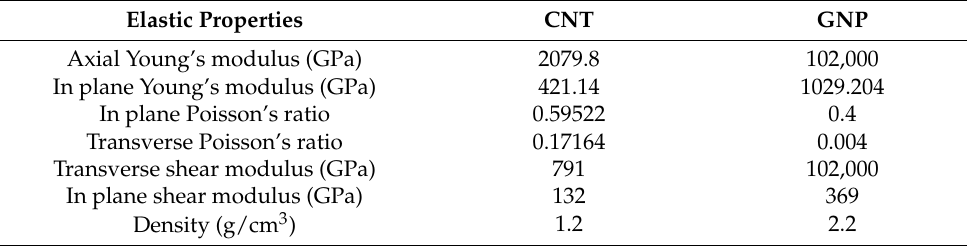
Table 4. Mechanical properties of CNT and GNP as inputs in Digimat